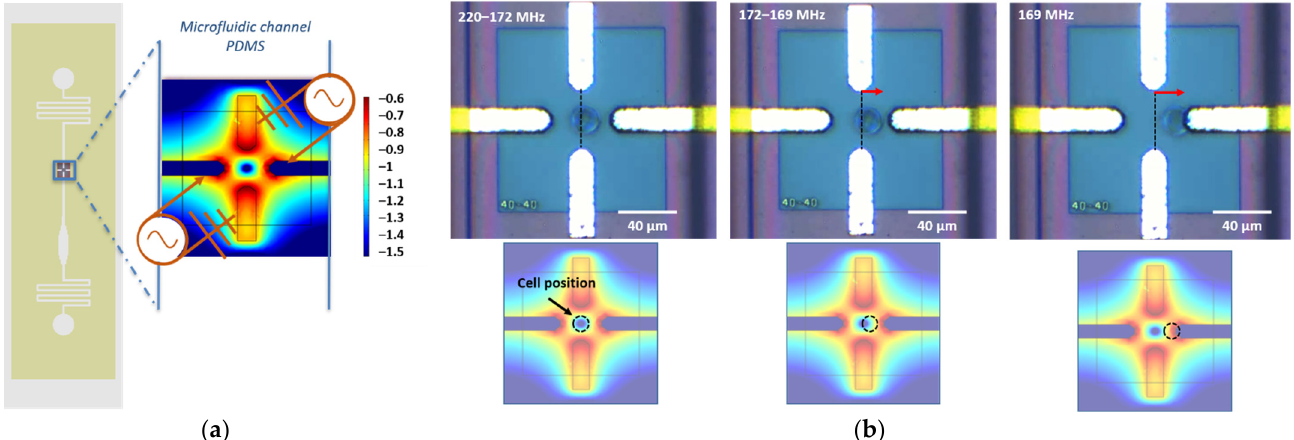
Figure 6. Principle of the crossover frequency measurement: ( a ) schematic of the microfluidic chip with a zoom in on one quadrupole sensor. Computation of the biased sensor in a non-uniform electric field (COMSOL Multiphysics ® ). The scale color corresponds to the normalized electromagnetic field intensity; ( b ) dielectrophoretic response of a single U87-MG NM cell under an UHF applied signal for frequencies between 220 and 169 MHz. The second crossover frequency f x02 is measured at 169 MHz.